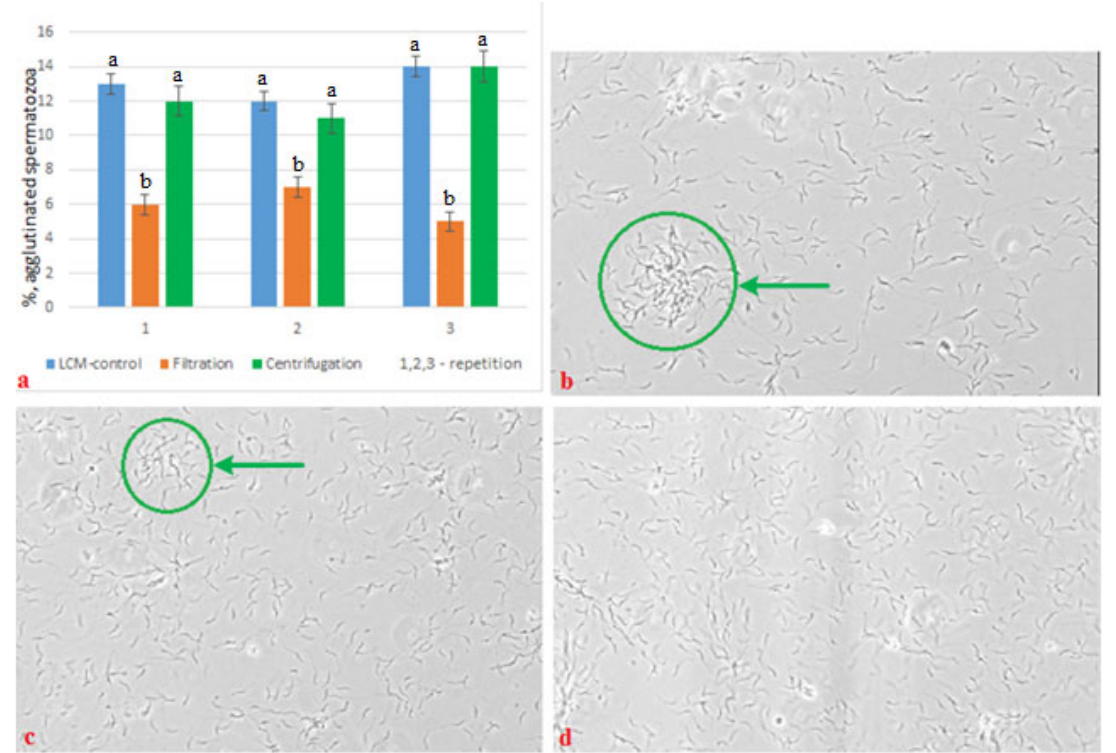
Figure 4. The degree of agglutination of frozen/thawed semen, depending on the method of its pro- cessing: ( a ) the degree of agglutination (%) of frozen/thawed semen, depending on the technological factors of preparation; ( b ) size of conglomerates of agglutinated frozen/thawed semen from aliquot I (LCM control); ( c ) the size of the conglomerates of the agglutinated frozen/thawed semen from aliquot II (filtration); ( d ) the size of the conglomerates of the agglutinated frozen/thawed semen from aliquot III (centrifugation). ( ←← designation of the area of agglutinated spermatozoa) ( p < 0.05).